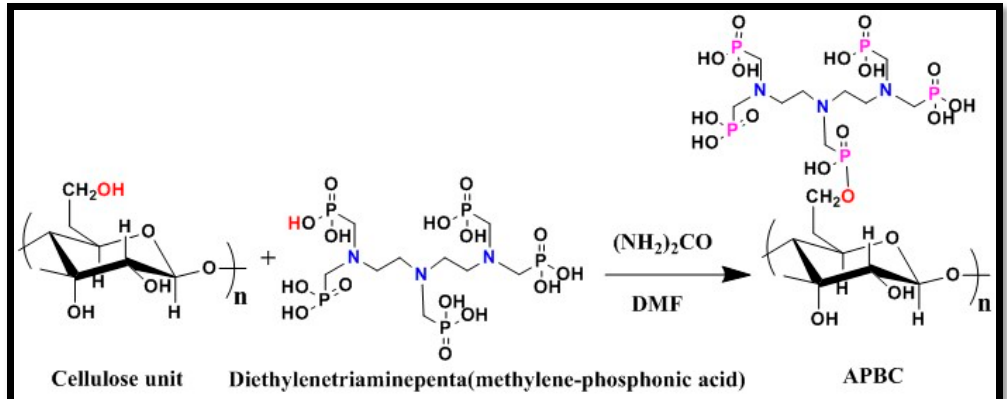
Figure 1. Schematic presentation of the surface modification of cellulose nanofibers.